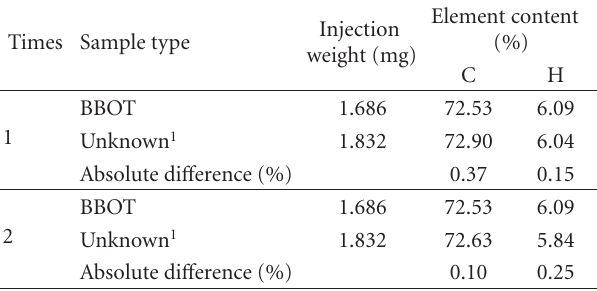
Table 2: Repeatability of elemental analysis for carbon (C) and hy- drogen (H) in